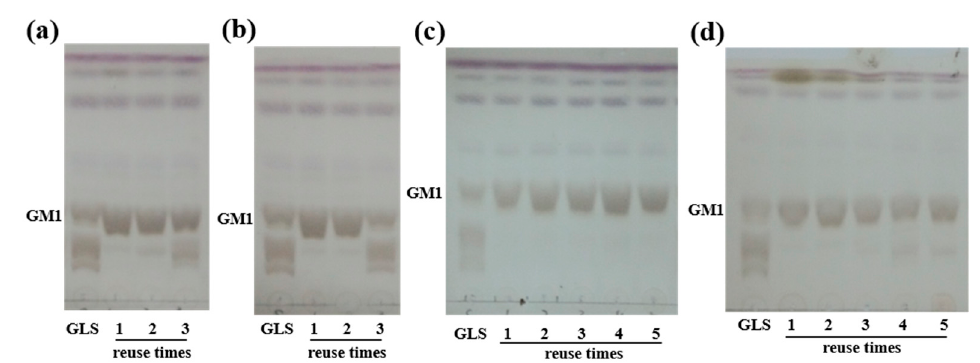
Figure 3. HPLC analysis of the product from GLS by immobilized sialidase with four di ff erent methods: ( a ) Fe 3 O 4 –CS; ( b ) acrylamide embedding; ( c ) sodium alginate embedding; and ( d ) sodium alginate embedding and cross ‐ linking.